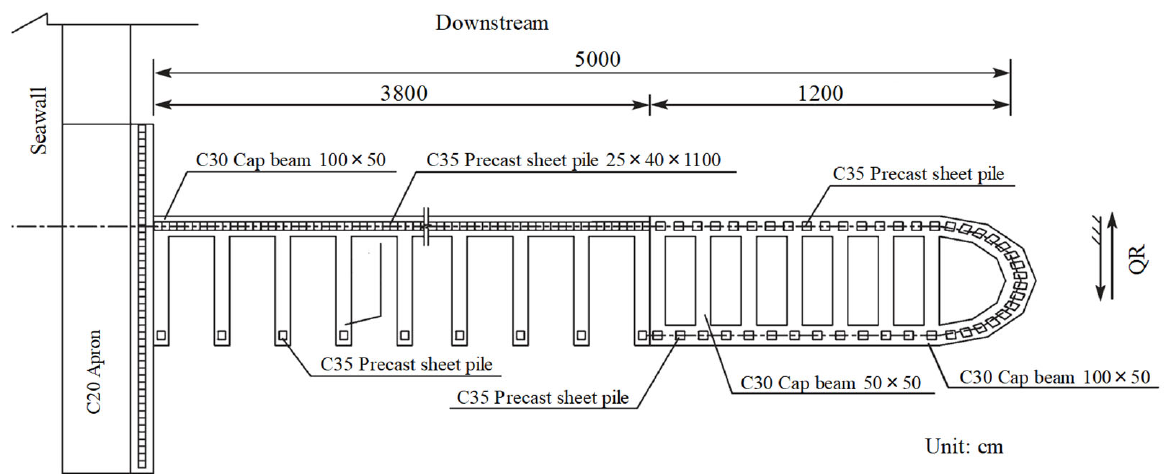
Figure 3. The plane layout of a sheet ‐ pile groin in the QR estuary.